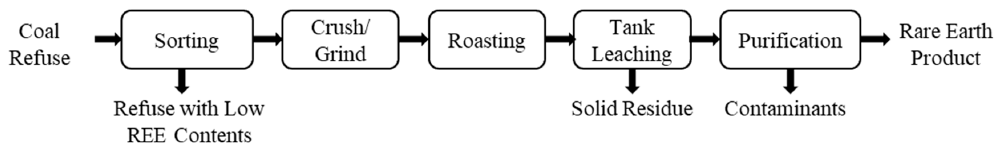
Figure 3. A simplified block diagram of the REE recovery process used in a REE pilot plant located in west Kentucky.